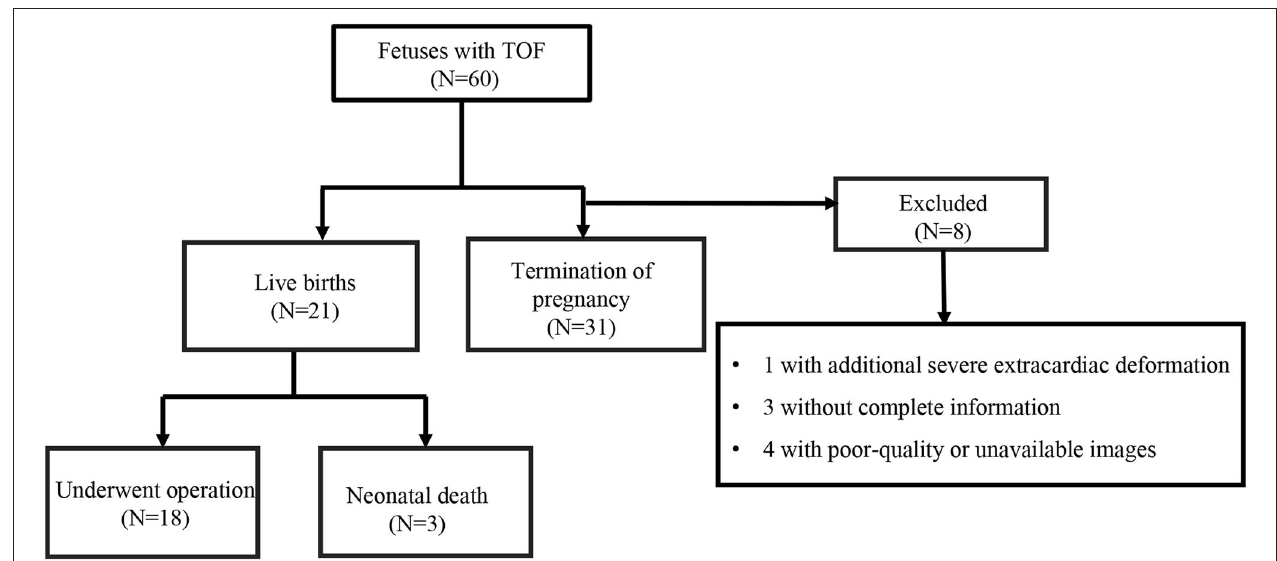
FIGURE 2 | A flow chart showing fetuses with tetralogy of Fallot (TOF) according to the inclusion and exclusion criteria.